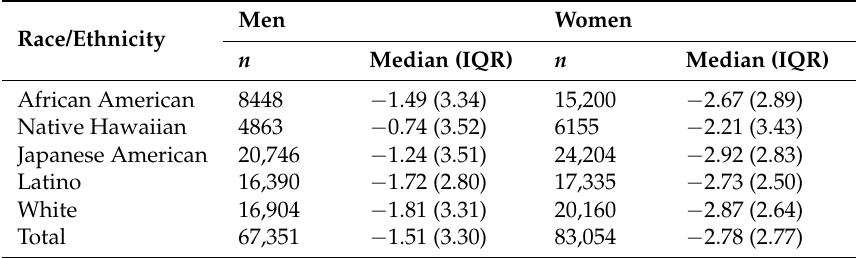
Table A1. Median and interquartile range (IQR) of Dietary Inflammatory Index (DII) scores by sex and race/ethnicity in the Multiethnic